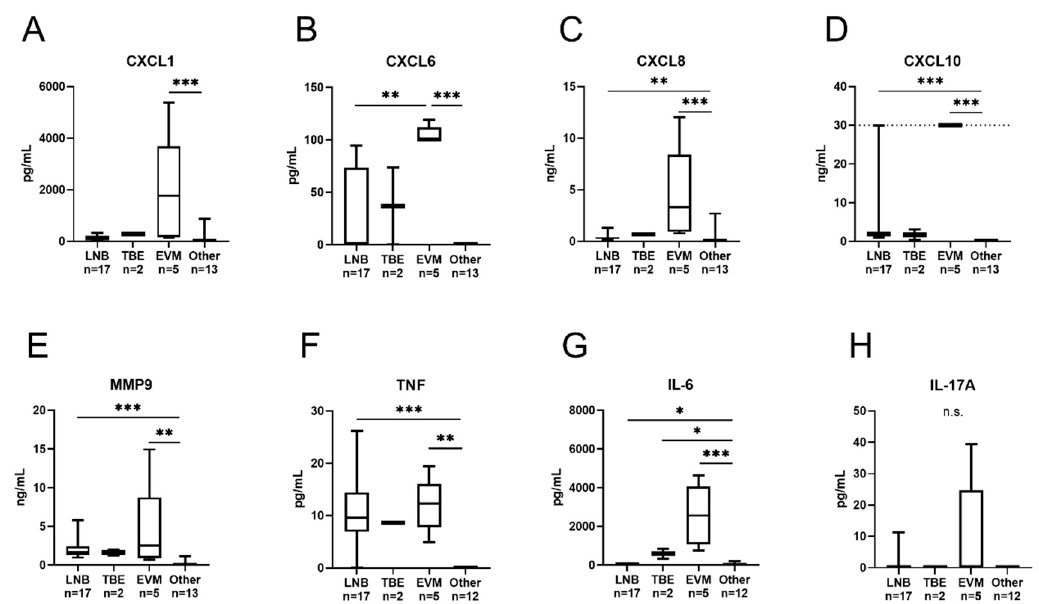
Figure 3. Concentrations of chemokines ( A – D ), MMP9 ( E ) and cytokines ( F – H ) in the CSF samples from the different patient groups. Whiskers indicate the min-max values. CXCL10 concentrations above the range of quantification (>30 ng/mL, N = 5) were assigned a value of 30 ng/mL (upper range of quantification is indicated by a dashed line). Only one child (rotavirus infection, no pleocytosis) belonged to the OVI group and is not included in the figure. LNB. Lyme neuroborreliosis; TBE, tick-borne encephalitis; EVM, enteroviral meningitis; Other, other non-infectious neurological and non-neurological disorders with CNS symptoms. * p < 0.05, ** p < 0.01, *** p < 0.001